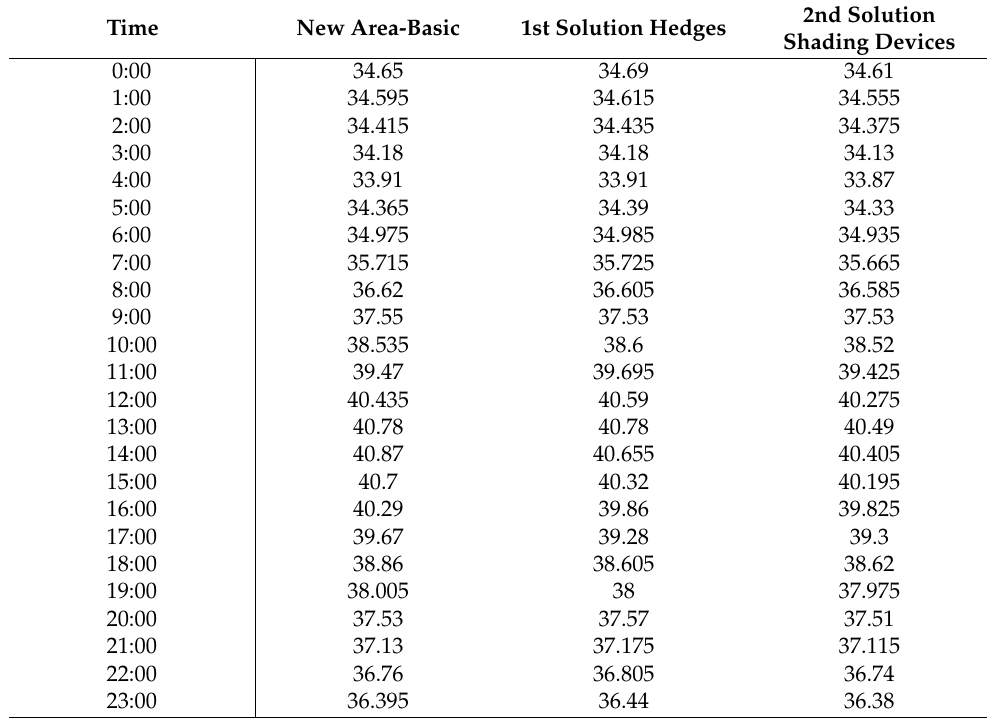
Table 6. Average potential air temperature for the base case and the solutions at 12:00 pm on 21st of August at height 1.8 m.